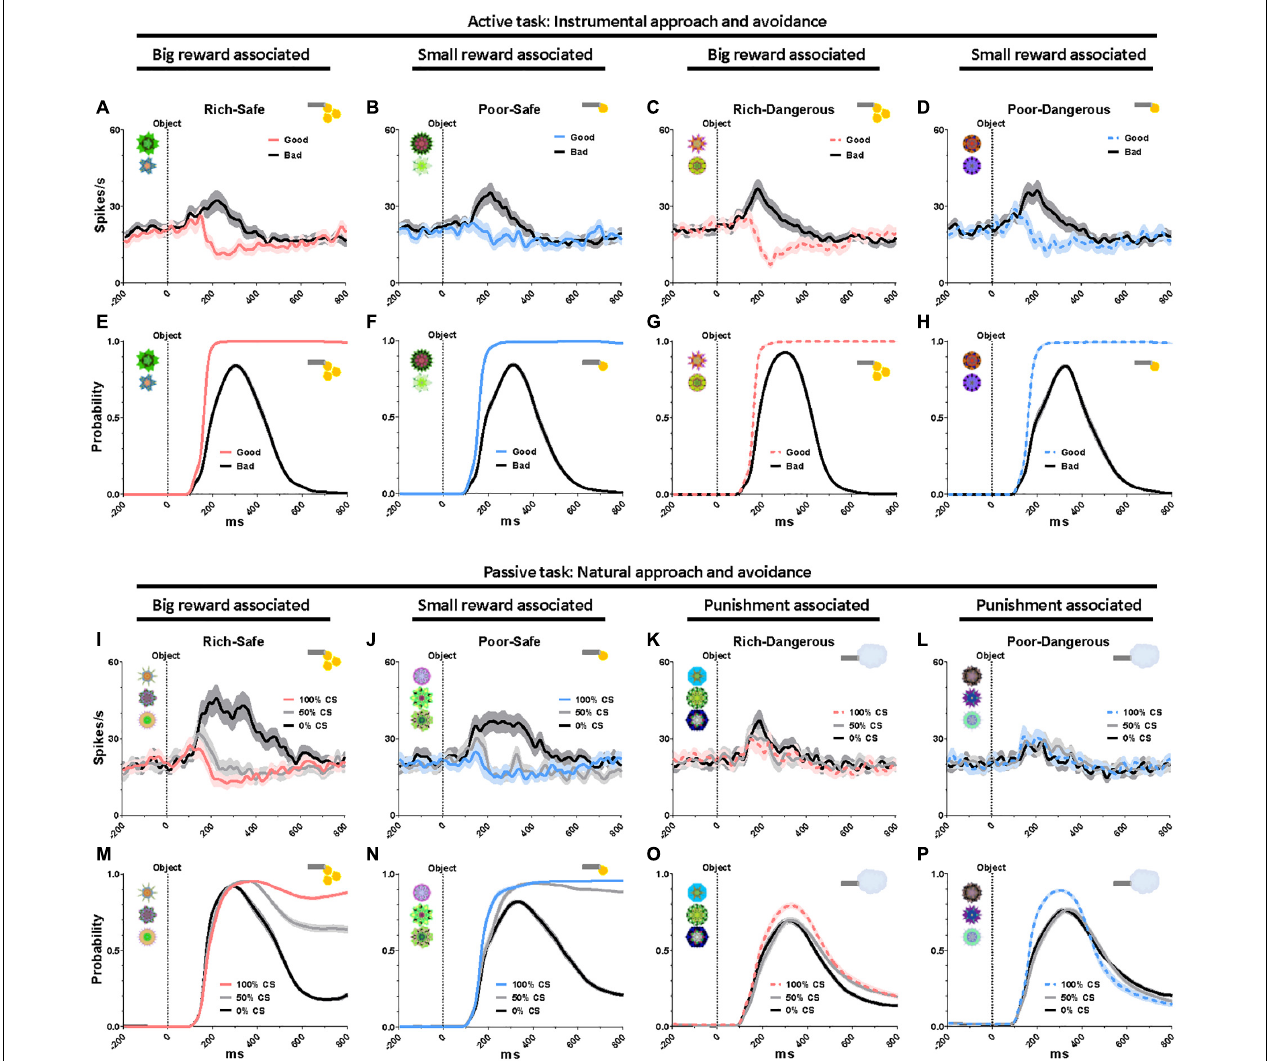
FIGURE 3 | Eye gaze to high- and low-valued objects. (A–D) LHb responses to good and bad objects during the active task. (E–H) Probability of gaze on good and bad objects during the active task. (I–L) LHb responses to the conditioned stimuli (CS) objects during the passive task. (M–P) Probability of gaze on the CS objects during the passive task. Data were from both monkeys and all recorded LHb neurons and behaviors averaged across entire